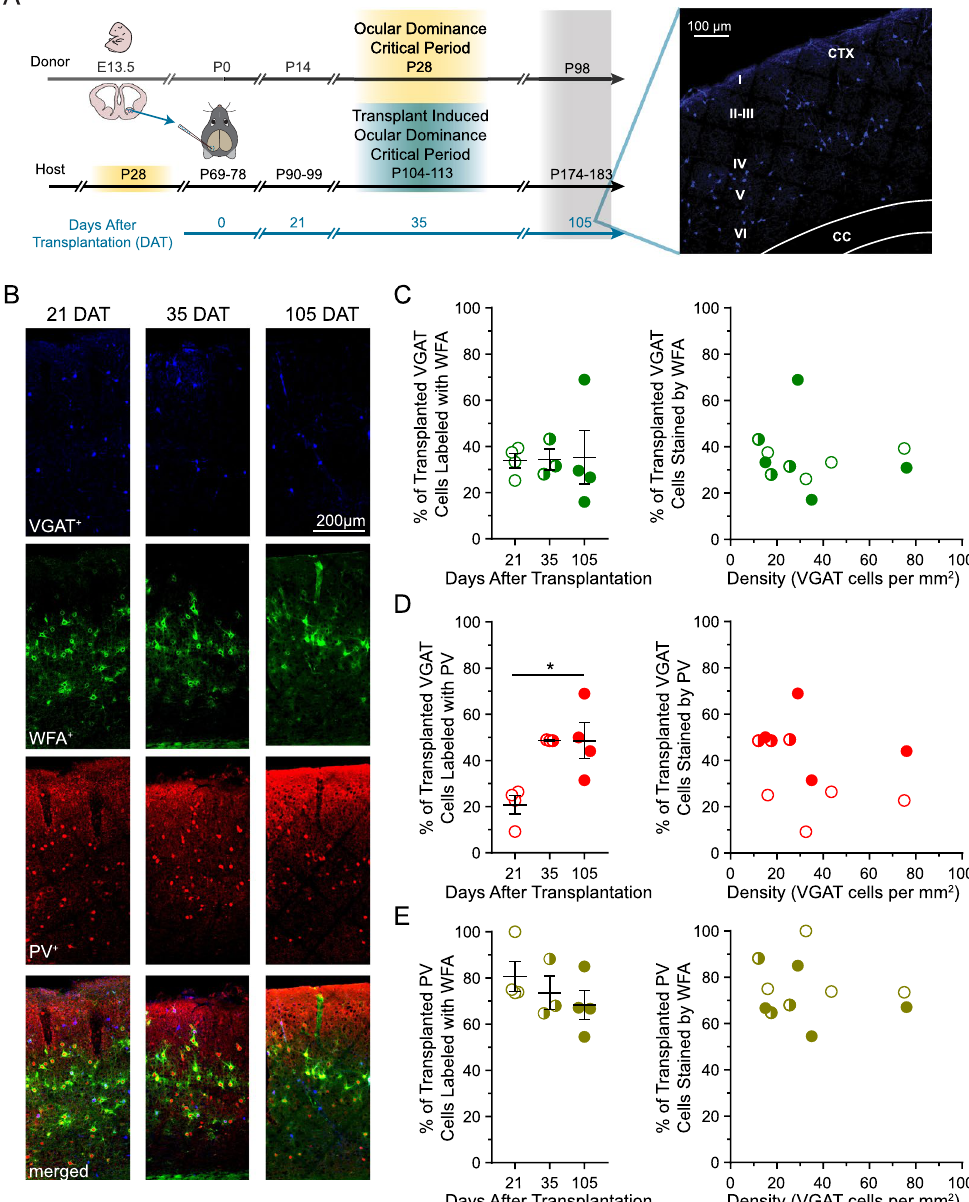
Figure 2. Precocious deposition of PNNs on transplanted PV inhibitory neurons. ( A ) Timeline of transplantation procedures (left) and coronal section 21 days after transplantation (right). Fluorescently-labeled cells from the medial ganglionic eminence of donors were dissected at embryonic day 13.5 and transplanted into adult visual cortex. Transplant recipients were perfused and analyzed 21, 35, and 105 days after transplantation (DAT) when the donor would have been P14, P28, and P98, respectively. Transplanted inhibitory neurons disperse across cortical layers I-VI (right). ( B ) Example sections of primary binocular visual cortex from transplant recipients at 21, 35, and 105 DAT. Transplanted VGAT neurons (blue) are stained with WFA (green) and PV (red). By 21 DAT, most transplanted inhibitory neurons that express PV are co-labeled with WFA. ( C ) Percentage of transplanted VGAT neurons stained by WFA (left) is similar among the three timepoints assessed (left: 21 DAT = 33.87 ± 3.12 (open), 35 DAT = 34.27 ± 4.59 (half-filled), 105 DAT = 35.27 ± 11.62 (filled)) and is not correlated with the density of transplanted cells (right). ( D ) In contrast, the percentage of transplanted VGAT neurons expressing PV (left) increases after 21 DAT (21 DAT = 20.84 ± 3.95 (open), 35 DAT = 48.71 ± 0.15 (half-filled), 105 DAT = 48.62 ± 7.81 (filled)). This increase in PV expression is not correlated with the density of transplanted cells (right). ( E ) Nonetheless, the percentage of transplanted PV neurons co-labeled with WFA (left) is stable across all timepoints assessed (21 DAT = 80.61 ± 6.47 (closed), 35 DAT = 73.65 ± 7.34 (half-filled), 105 DAT = 68.34 ± 6.27 (filled)). The density of transplanted neurons is not correlated with the percent of transplanted PV cells co-labeled with WFA (right).